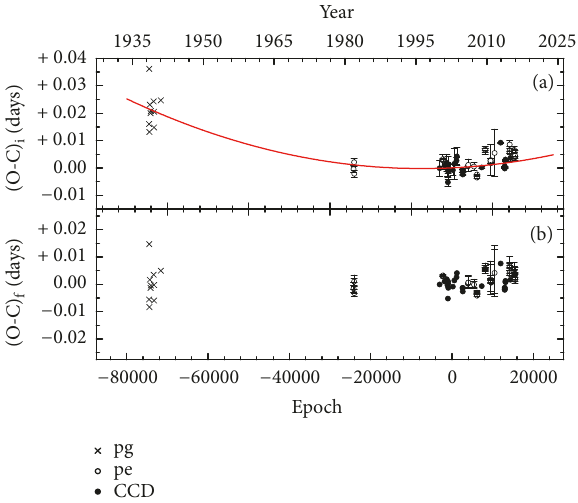
Figure 4: The (𝑂 − 𝐶) curve for MT Cas. The crossing, open, and solidcirclesrepresentphotographicdataandphotoelectricandCCD measurements, respectively. The continuous line is plotted by Eq. (2).